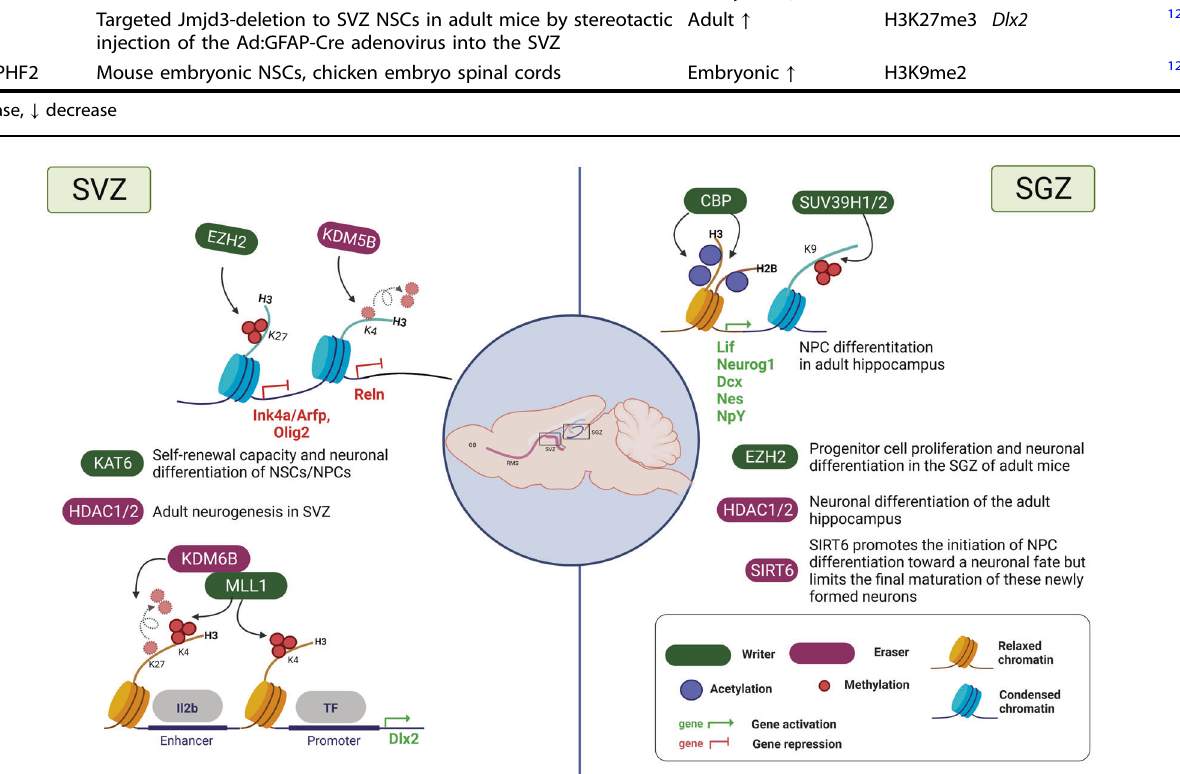
Fig. 4 Histone modi fi cations during adult neurogenesis. In SVZ, KAT6 and HDAC1/2 regulate neurogenesis. HMTs (MLL1 and EZH2) and HDMs (KDM5B and KDM6B) regulates gene expression related to neurogenesis. In SGZ, HAT (p300), HDACs (HDAC1/2 and SIRT6), and HMTs (SUV39H1/2 and EZH2) promote neural differentiation by regulating gene expression